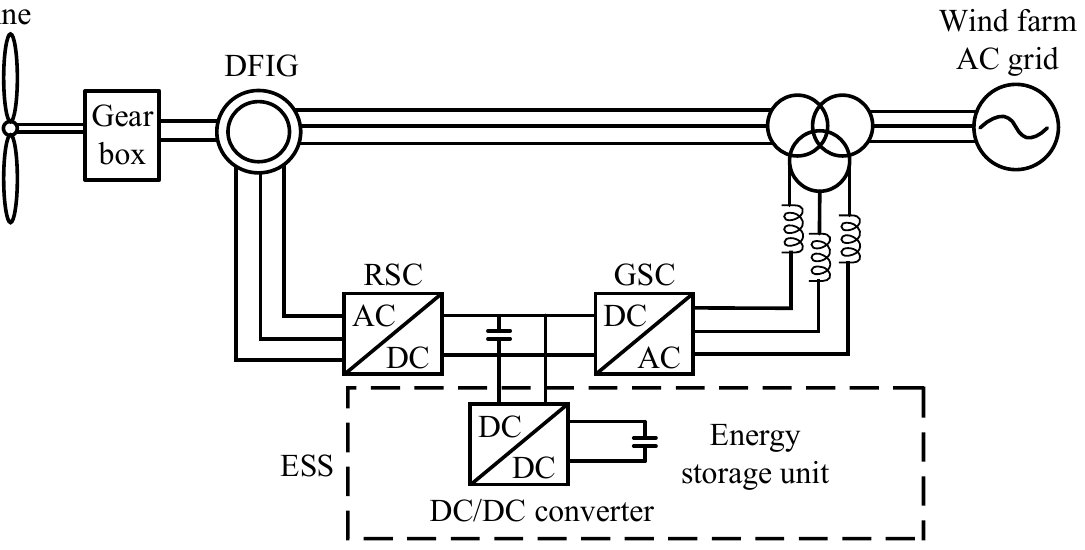
Figure 3. Structure of a DFIG WT equipped with an ESS.